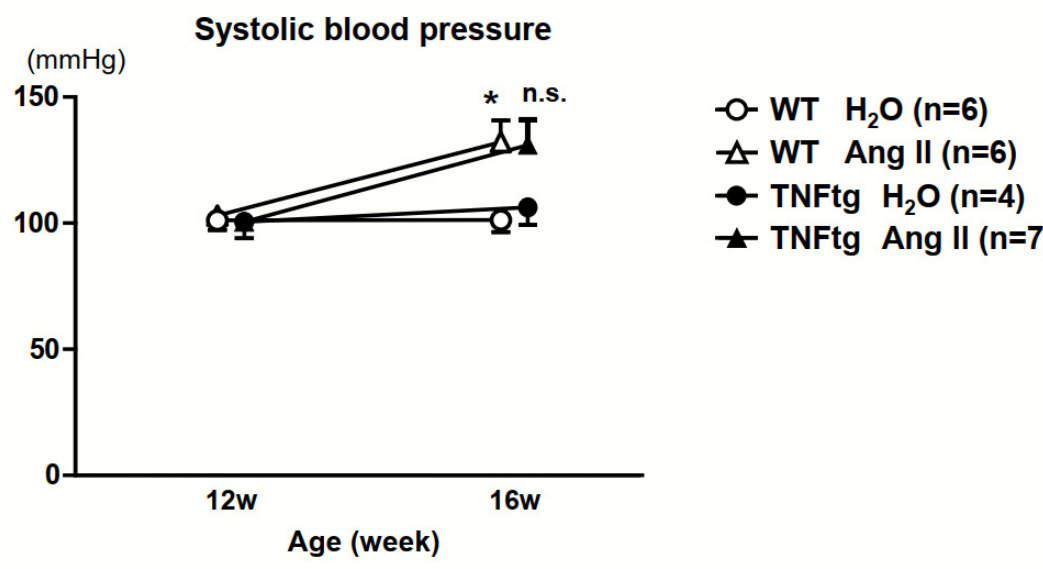
Figure A2. Systolic blood pressure in wild-type (WT) and tumor necrosis factor-transgenic (TNFtg) mice administered angiotensin II (Ang II) and water (H 2 O). Ang II was administered by osmotic pumps to WT and TNFtg mice from 12 to 16 weeks of age. Values are the mean ± SEM. *, p < 0.05 (WT (Ang II) vs. WT (H 2 O)). n.s., not significant (TNFtg (Ang II) vs. TNFtg (H 2 O)).